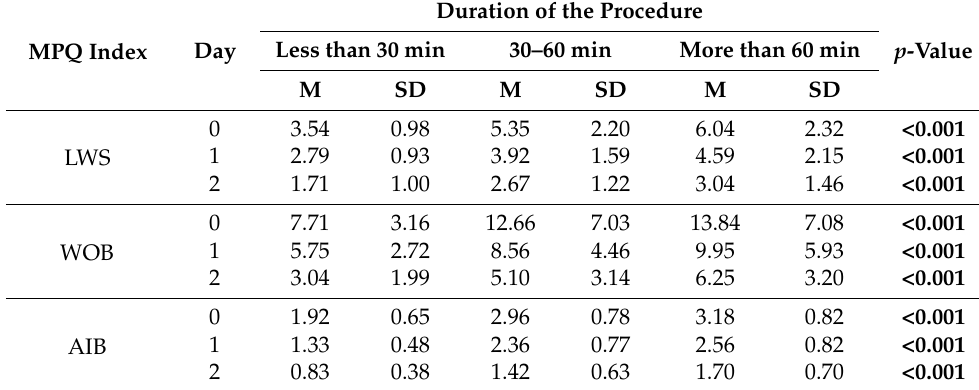
Table 3. Pain and the duration of the procedure.